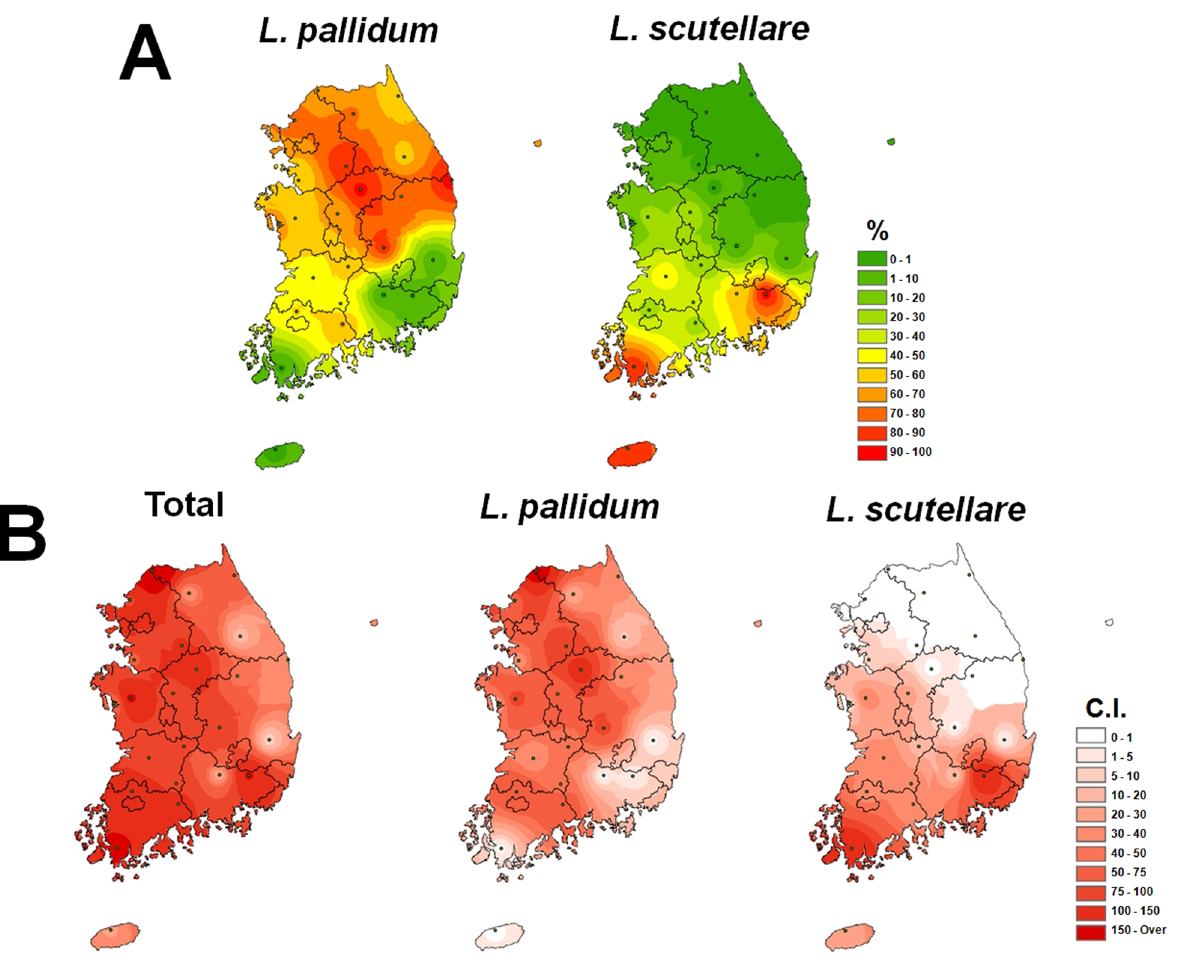
Fig. 5. Geographical distribution based on percentages (A) and C.I. (B) of L. pallidum and L. scutellare . Chigger index (C.I.) indicates the number of chigger mites on one small